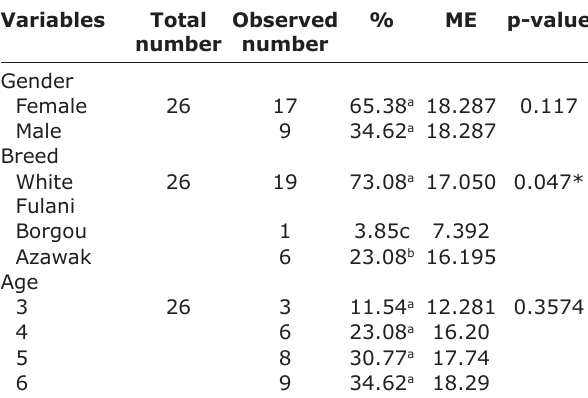
Table-4: Bovine TB incidence according to gender, breed, and age.